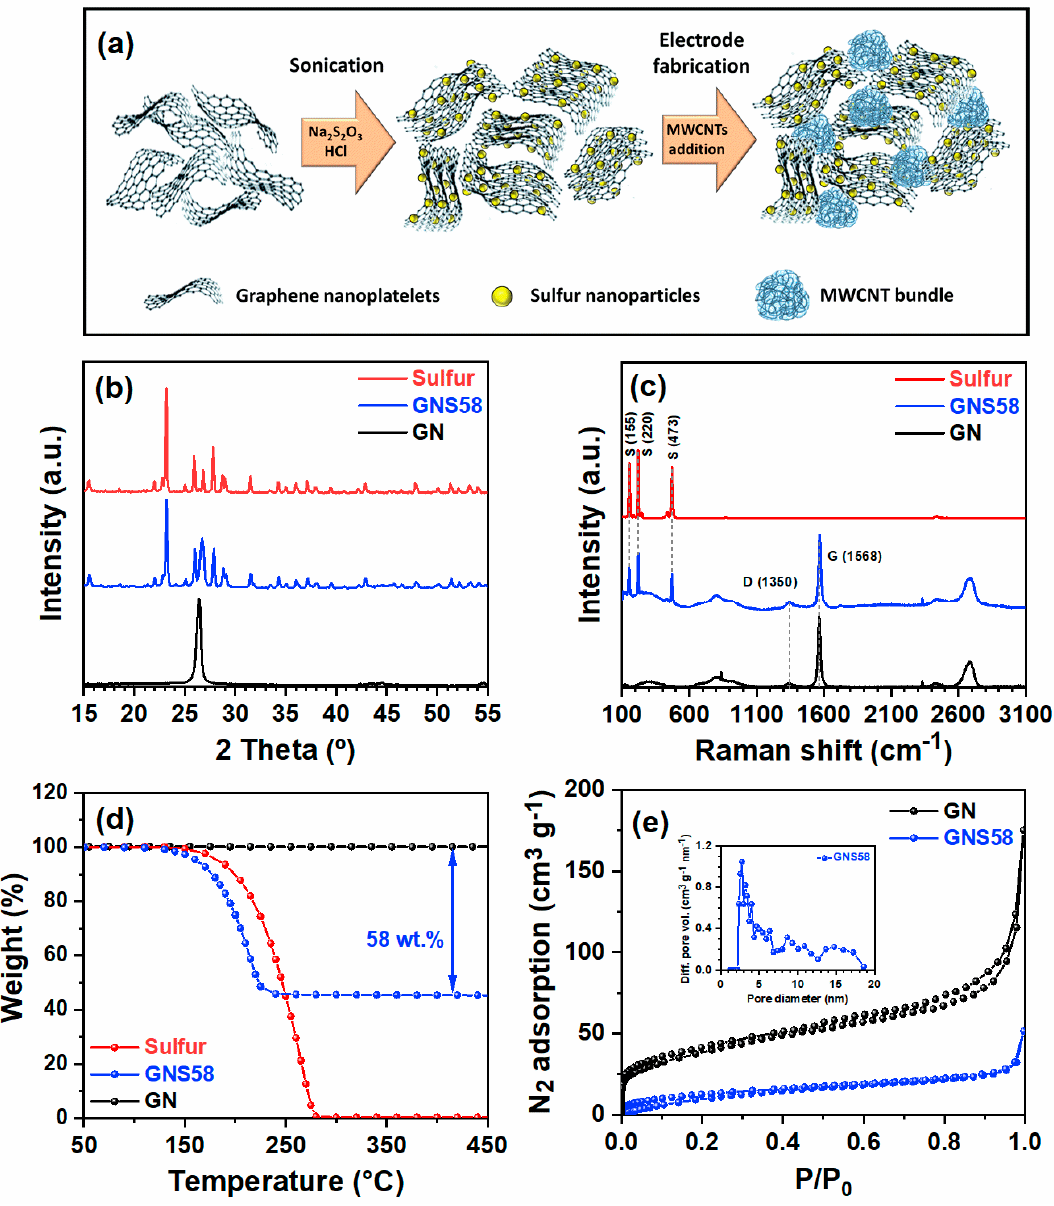
Figure 1. ( a ) Schematic of the synthesis of multidimensional GNS58-CNT10 hybrid cathode. ( b ) X-ray diffraction patterns, ( c ) thermogravimetric analysis and ( d ) Raman spectra of graphene nanoplatelets, elemental sulfur and GNS58 powder. ( e ) N 2 adsorption-desorption isotherms of graphene nanoplatelets and GNS58 powder and pore size distribution of GNS58 (inset).